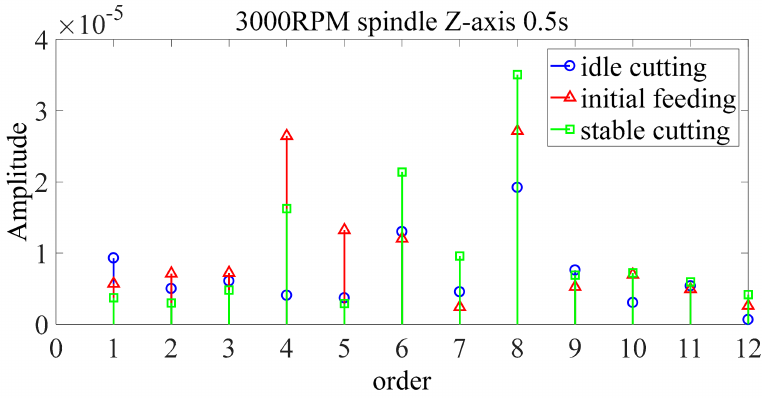
Figure 8. Order spectrum at Z axis at 3000 rpm; complete